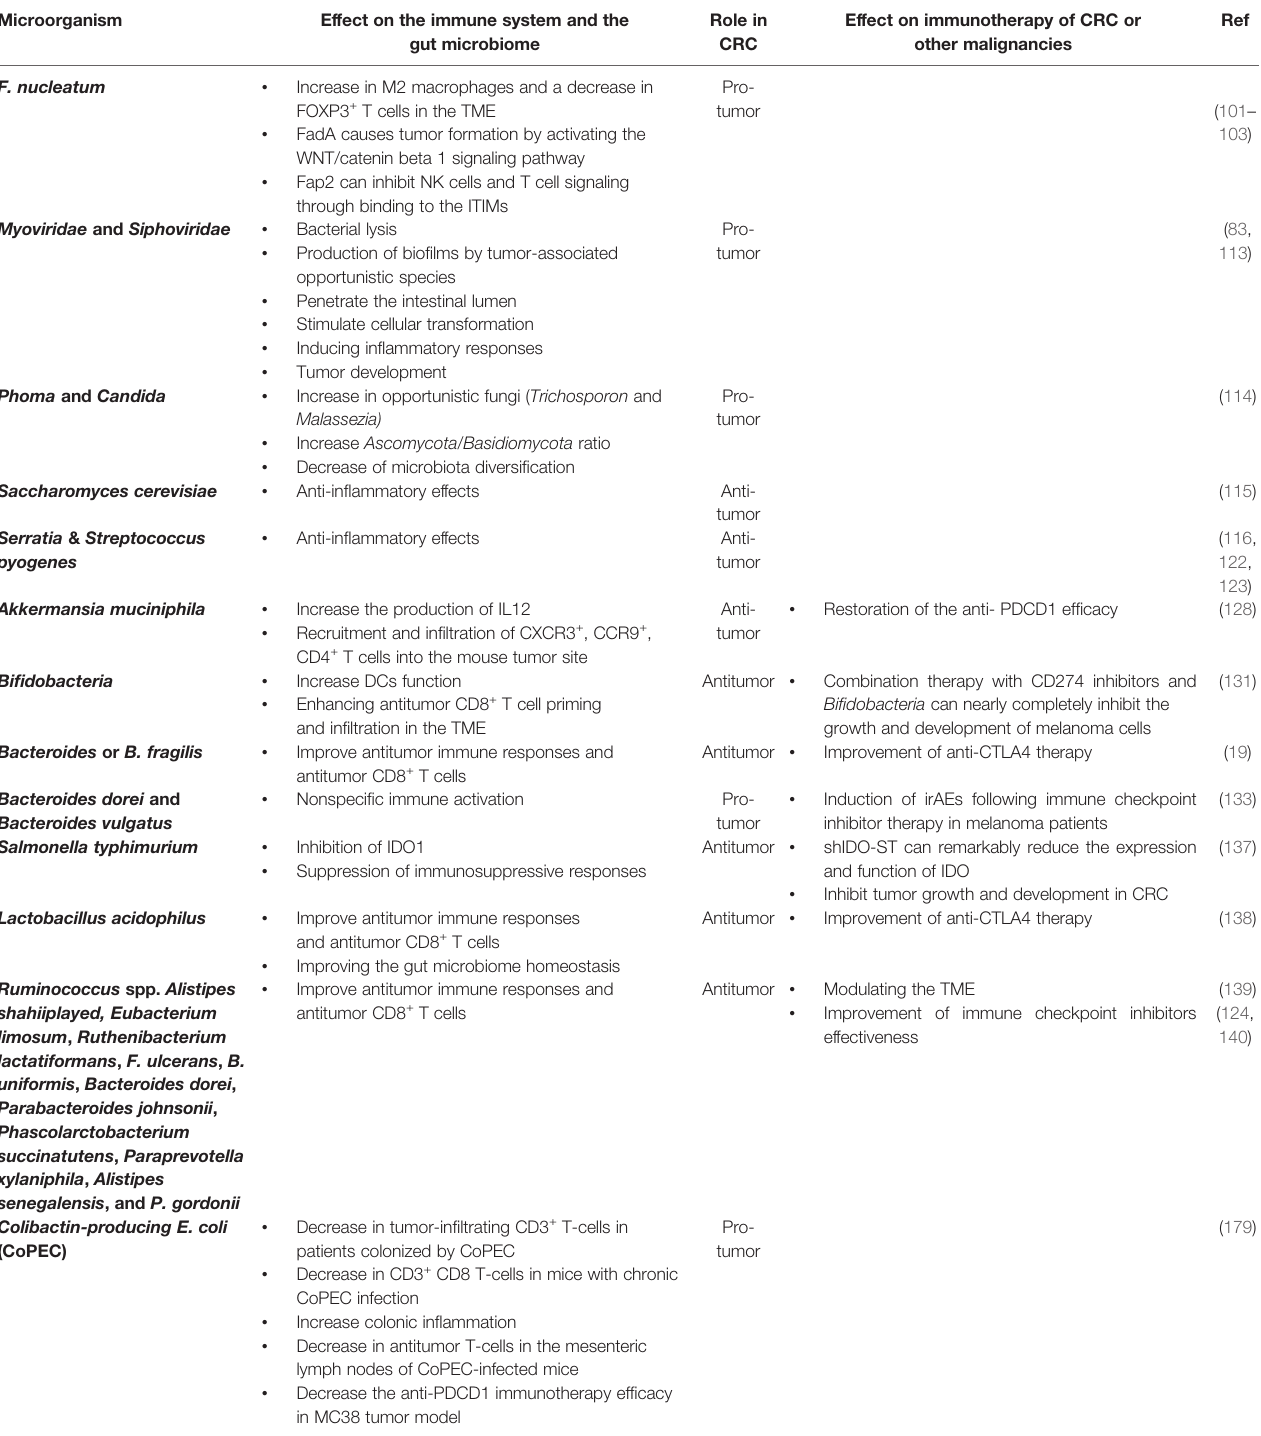
TABLE 1 | Effects of different microorganisms on the immune system, the gut microbiome, and immunotherapy.